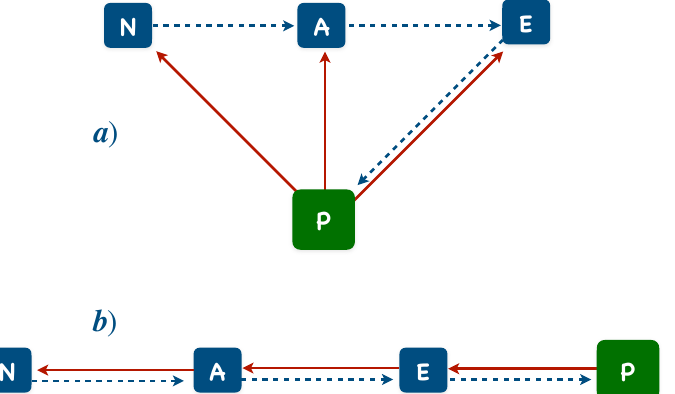
Figure 2. ( a ) Direct (D) and ( b ) phase-in (P) knowledge-transfer methods. The solid (red) arrows indicate the knowledge flow transfer whereas the dashed (blue) arrows indicate the population flow between the distinct sectors. N is the population of new individuals, A the population of individuals acquiring technical knowledge, E the population of individuals experimenting with the technical knowledge and P the population of individuals able to produce or extract the natural resource, see Table 1. The figure is own